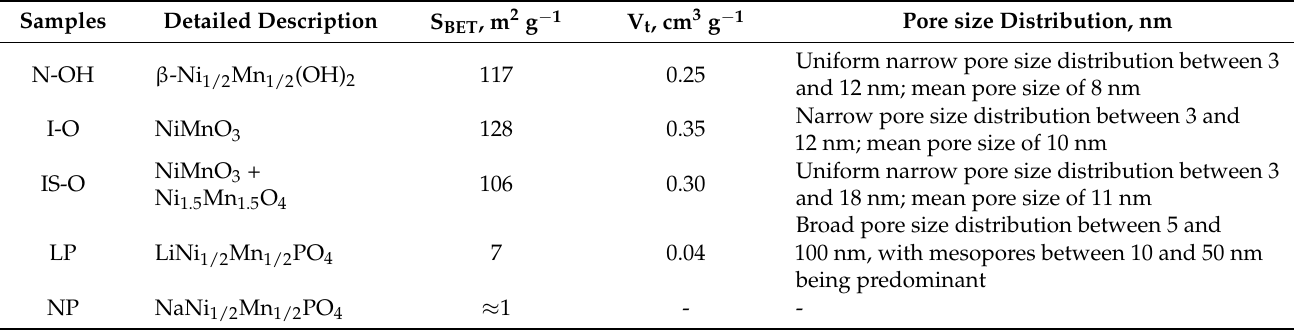
Table 2. Specific surface area S BET , total pore volume V t and pore size distribution for the studied